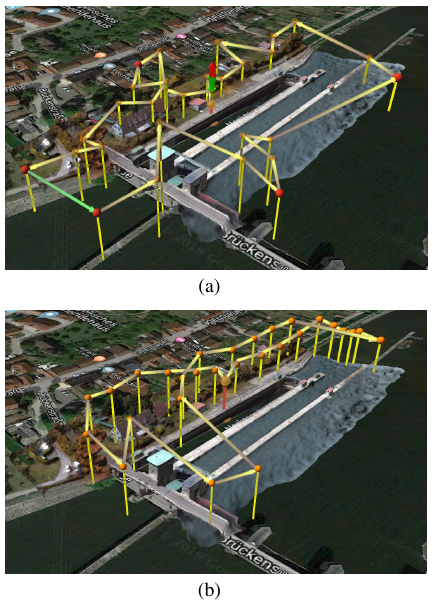
Figure 7. Histogram of the maximum dimension of the error ellipsoid of tie points. (a) Nadir, (b) 3D, (c) MS. Figure 5. 3D flight paths. (a) proposed (3D); (b) Metashape’s low rectangles represent zoom in areas in the following rows. In Zoom #1, the fac¸ade of the center ship lock building was well- reconstructed in the flight 3D , however, the result from flight MS was as incomplete as the Nadir one. Zoom #2 was a small building on the ship lock. The result from Nadir and MS was barely the same while there were some points on the fac¸ade in our result. In Zoom #3, the result from Nadir and MS were lack fully captured the data Figure 6. The total error of each checkpoint. The horizontal red dash line marks the 3GSD error, 3.87 cm.